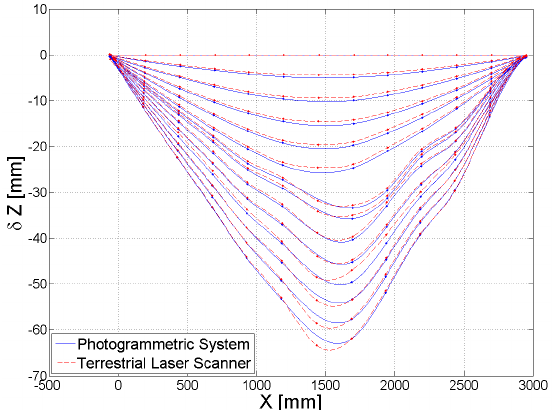
Figure 12. Cubic spline plots of the beam deflections computed using the photogrammetric reconstruction vs. the terrestrial laser scanner for the second